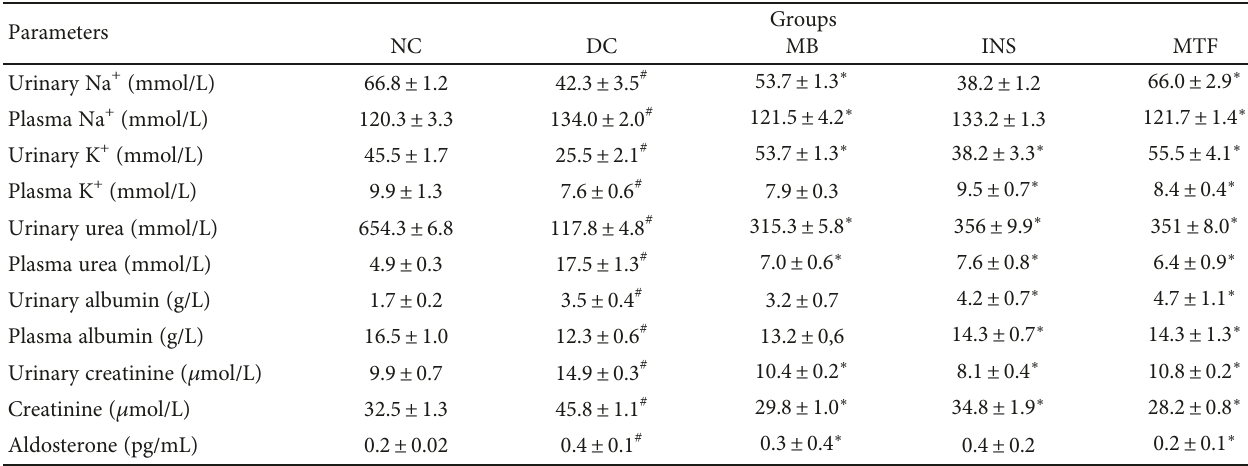
Table 2: Comparison of plasma biochemical parameters and urinary electrolytes of nondiabetic controls, diabetic controls, and diabetic rats treated with MB, metformin, and insulin during a 5-week study ( n = 6 in each group). Values are expressed as mean ± SEM . Parameters